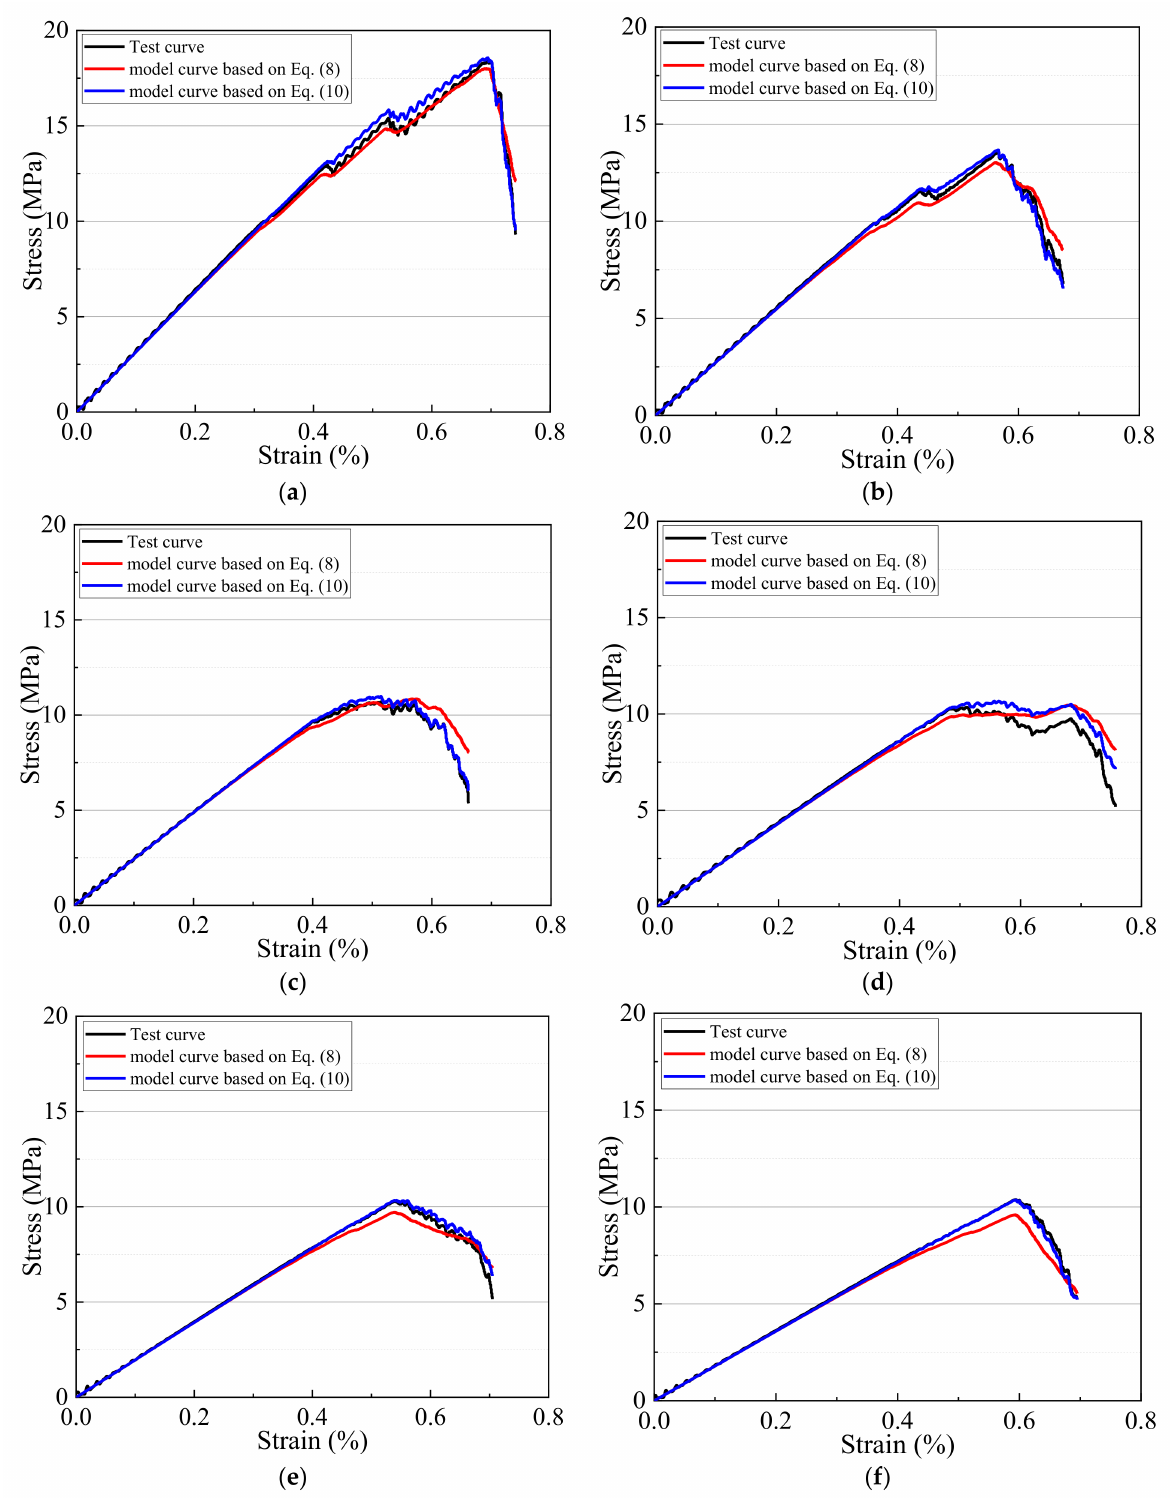
Figure 13. Damage constitutive model curves and tests curves: ( a – f ):